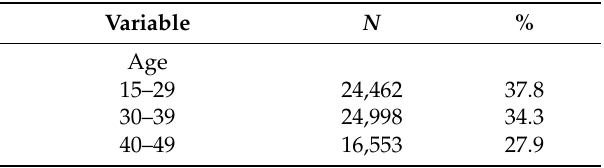
Table 1. Sociodemographic sample characteristics of the domestic violence module of the India National Family Health Survey (NFHS-4) ( N =